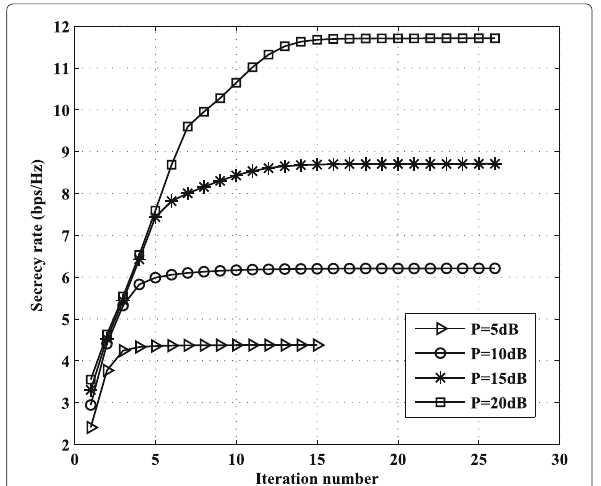
Fig. 2 DC algorithm: convergence of the secrecy